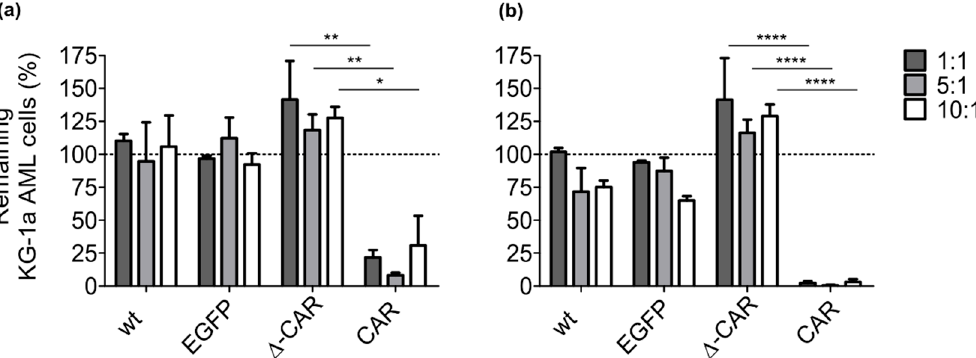
Figure 2. Co-culture experiments showed that CAR-NK-92 effector cells efficiently eliminated CD123 + KG-1a target cells. Different NK-92 cell groups (unmodified controls (wt), EGFP controls, Δ -CAR-, or CAR-modified) were tested for their activity against the AML cell line KG-1a. Co-cultures were accomplished at different effector:target (E:T) ratios (1:1, 5:1, 10:1) as indicated, and the loss of KG-1a cells was quantified at ( a ) 24 h and ( b ) 48 h after initiating co-culture experiments. KG-1a target cells were genetically modified to express the red flourescent protein DsRed to ease quantification by flow cytometry. Results from three experiments are shown. Mean values with standard deviations of KG-1a cells remaining after co-culture are given. Two-way ANOVA with Bonferroni multiple comparisons was used to compare cytotoxic activity. Statistically significant differences are indicated by * ( p ≤ 0.05), ** ( p ≤ 0.01), **** ( p ≤ 0.0001). The dotted lines in the graphs serve as a reference for the percentage of KG-1a cells determined at initiation of the co-culture, which was set to 100%.